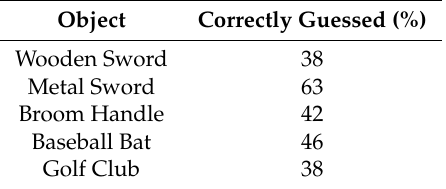
Table 10. Objects identified from Wii Controller; tested after the listening